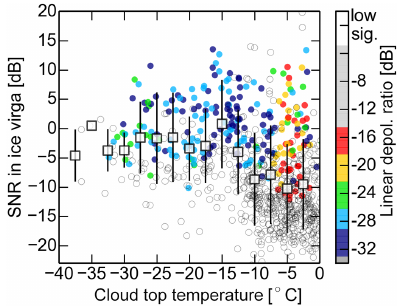
Figure 6. The 90% percentile of cloud radar SNR is shown for each cloud case together with mean detected LDR. For ± 2.5 ◦ C intervals mean values (white squares) and standard deviation (black bars) are